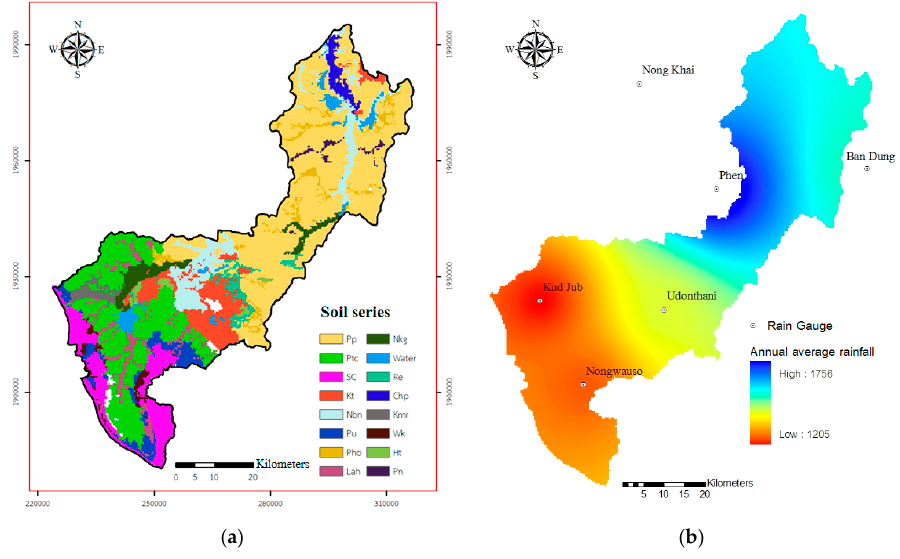
Figure 2. ( a ) Soil series and ( b ) location of rain gauge stations in the Huai Luang Watershed.